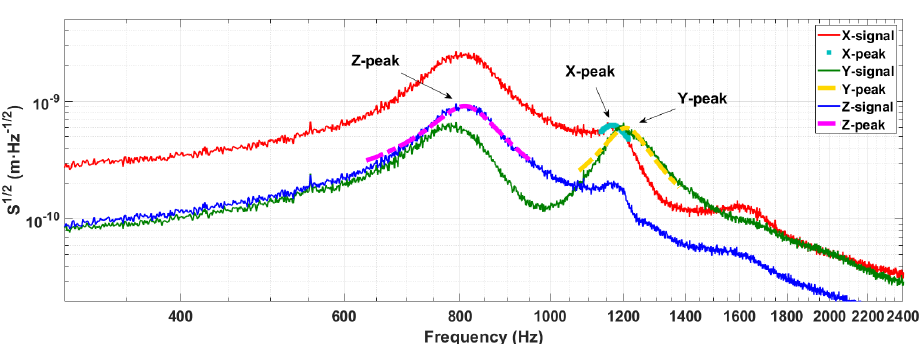
Figure 2. Coupling phenomena while trapping a 10 µ m-diameter sphere at 9.4 mBar in the experiment. The ordinate represents the root of three-dimension displacement power spectrum density of the particle. The red, green and blue lines represent the signals obtained from the detectors in the x , y and z directions, respectively. The dashed lines indicate that the fitted resonance peaks in three directions and the two radial resonant frequencies are close. The radial spectrum is only coupled seriously by axial signals and vice